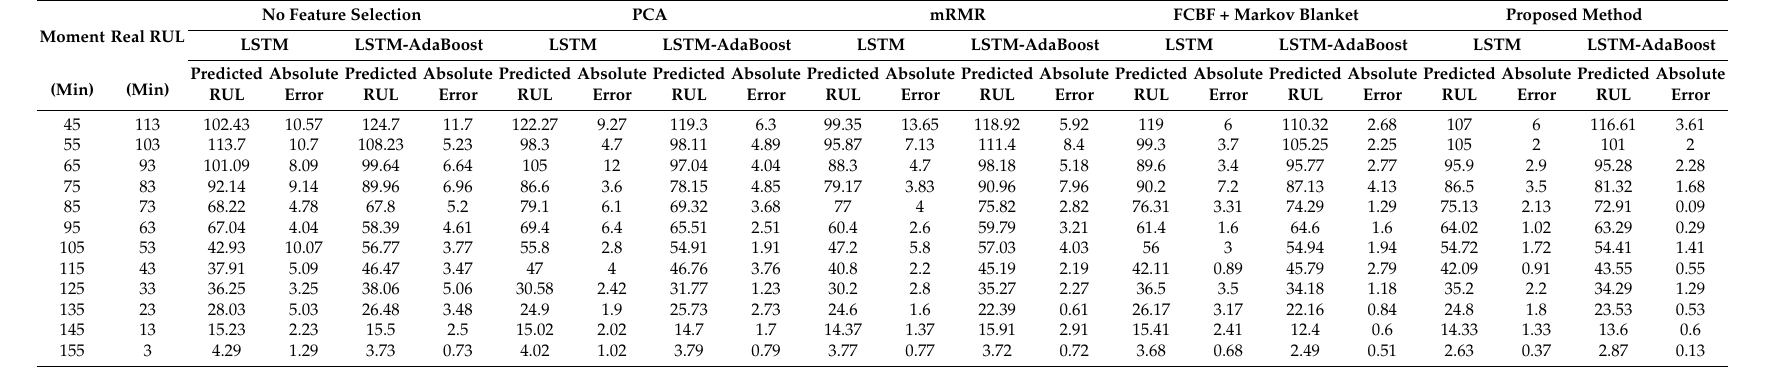
Table 4. Comparison of prediction results of bearing 1_3 using different